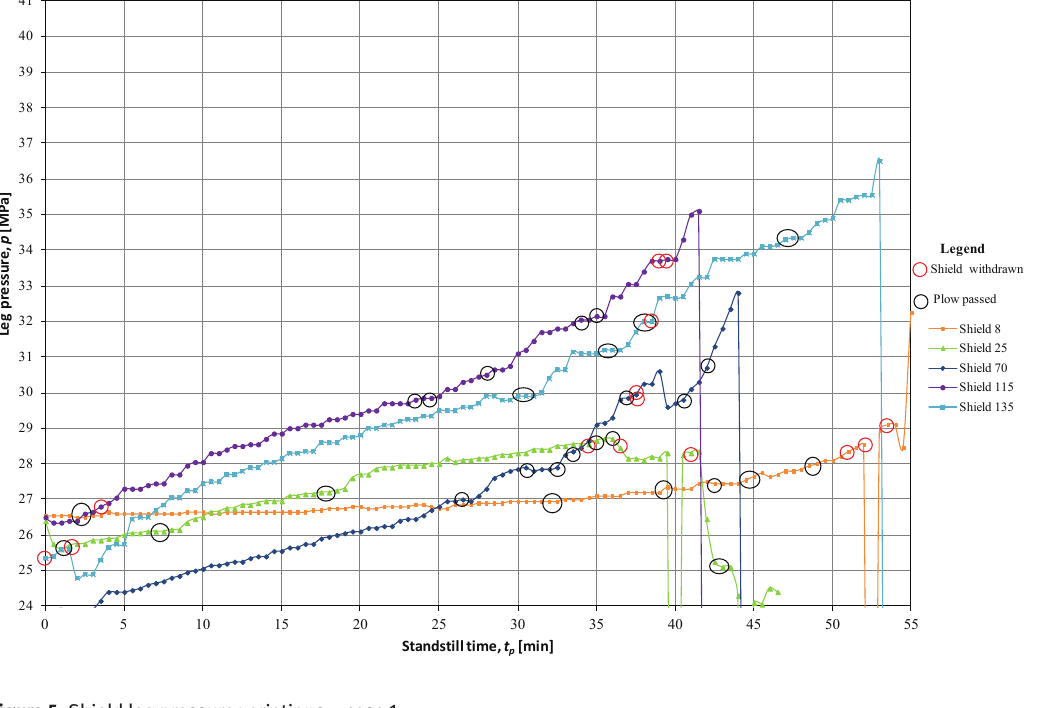
Figure 5: Shield leg pressure variations – case 1.